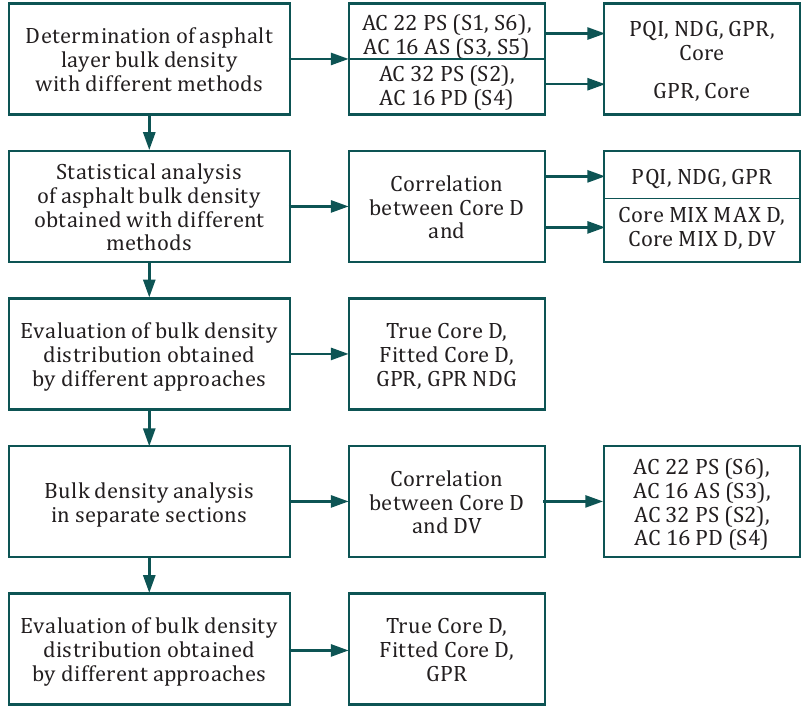
True Core D, Fitted Core D,